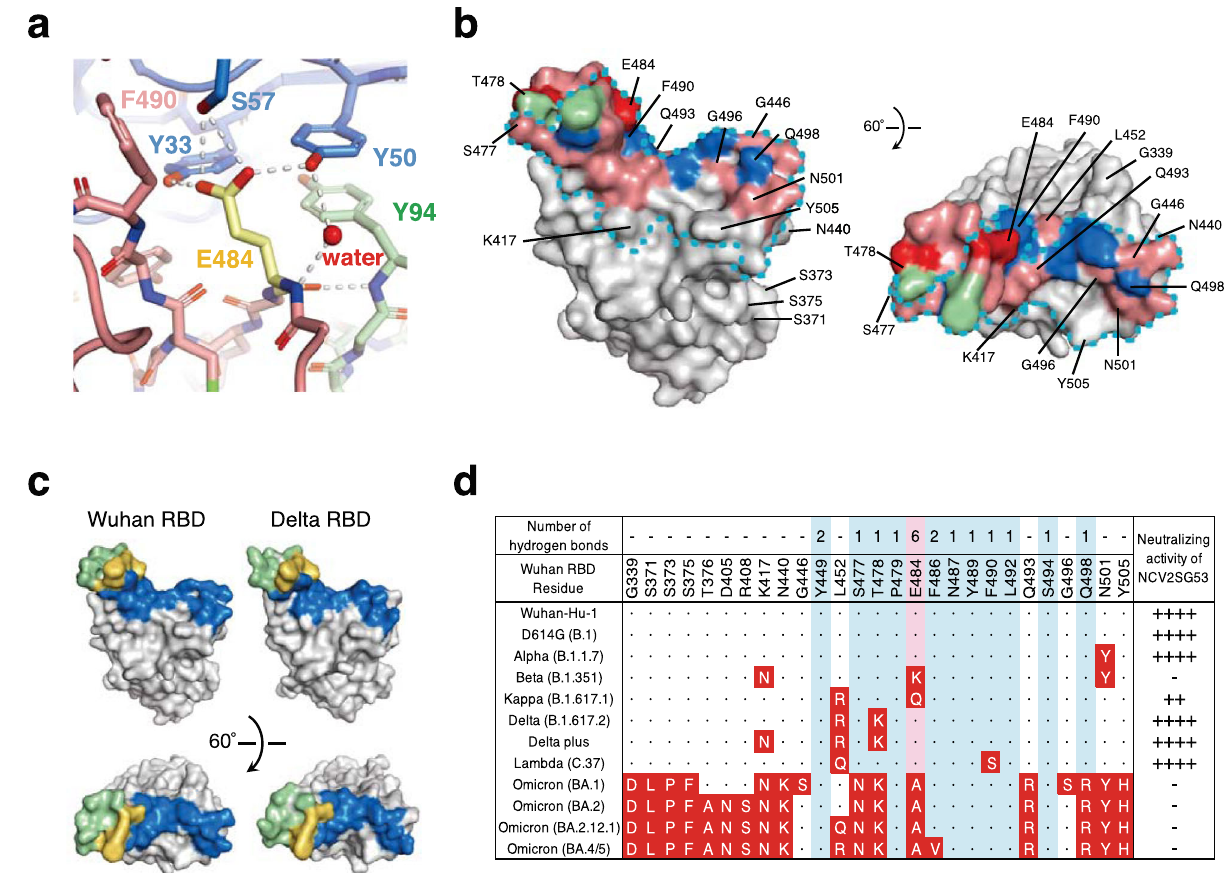
Fig. 6 SHM contributed to hydrogen bonds between NCV2SG53 and E484 residue of RBD. a Interaction of RBD E484 residue with NCV2SG53 mAb through the multiple hydrogen bonds. Among hydrogen bonds formed on RBD E484, S57 residue in the NCV2SG53 heavy chain CDR2 was generated by the SHM and contributes to increased binding af fi nity. b NCV2SG53-RBD binding interface on the Wuhan RBD surface model. Residues forming a hydrogen bond with HC ( blue ) and LC ( green ) are indicated. Hydrogen bonds generated by SHM ( red ) are shown on the binding interface ( pink ). The ACE2- binding site is surrounded by a dotted line ( cyan ). c Comparison of the NCV2SG53 binding interface between Wuhan RBD and Delta RBD. The binding interface of HC ( blue ), LC ( green ), or HC/LC overlapped ( yellow ) is shown on the surface model of RBD. d The matrix represents amino acid substitutions present in RBD of indicated SARS-CoV-2 variants. The substituted amino acids are shown in red boxes. The numbers of hydrogen bonds of NCV2SG53 to Wuhan RBD are indicated on the corresponding amino acid residue. Residues of blue interact with SARS-CoV-2 RBD. E484 in RBD is the most important for binding with NCV2SG53 ( pink ). Mutation in the E484 residue of SARS-CoV-2 RBD reduces the binding of NCV2SG53. IC 50 of neutralizing activity of NCV2SG53 to SARS-CoV-2 pseudoviruses is indicated (IC 50 : ++++ , <10 ng/ml; ++ , 100 – 999 ng/ml; − , >1000